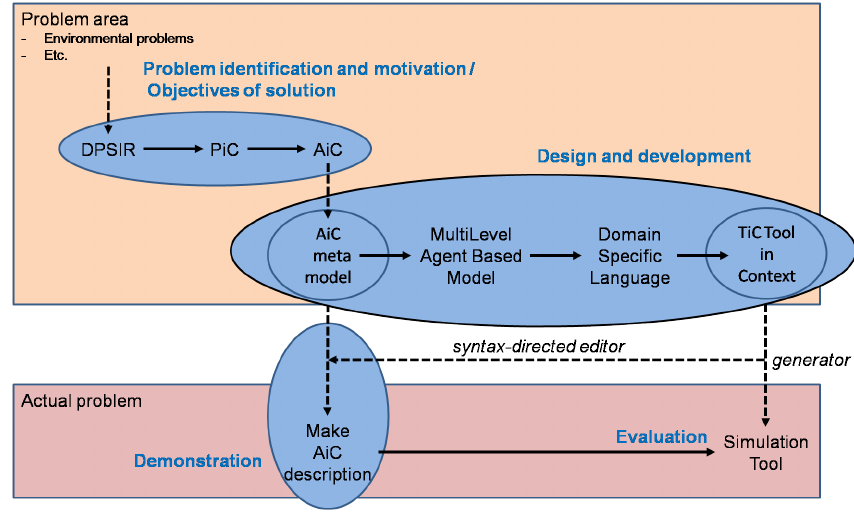
Figure 1. The various levels of abstraction and application (DPSIR -